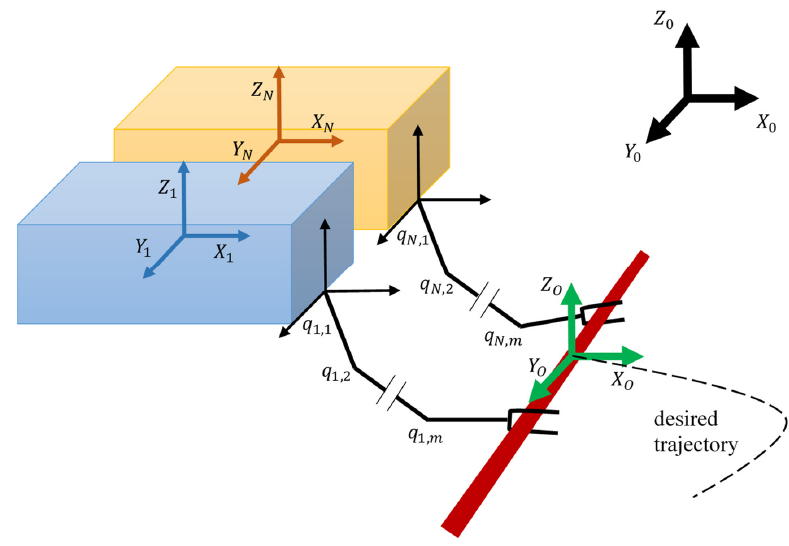
Figure 1. Schematic representation of two underwater robots with manipulators as a cooperative system.